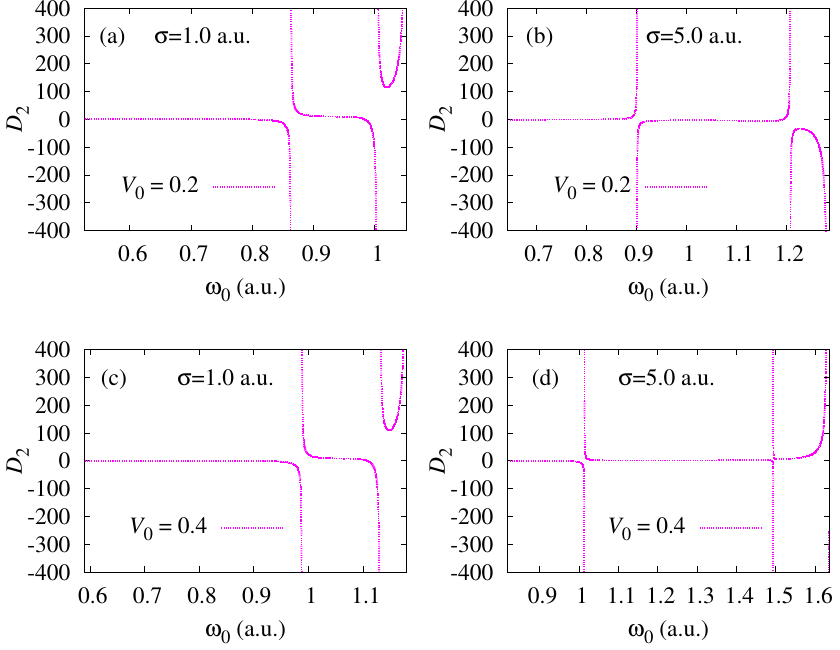
Figure 3. Variation of two-photon 1 s → 4 s transition probability amplitude with frequency of incoming photons, ω 0 , for ( a ) V 0 = 0.2 a.u. and σ = 1.0 a.u.; ( b ) V 0 = 0.2 a.u. and σ = 5.0 a.u.; ( c ) V 0 = 0.4 a.u. and σ = 1.0 a.u.; ( d ) V 0 = 0.4 a.u. and σ = 5.0